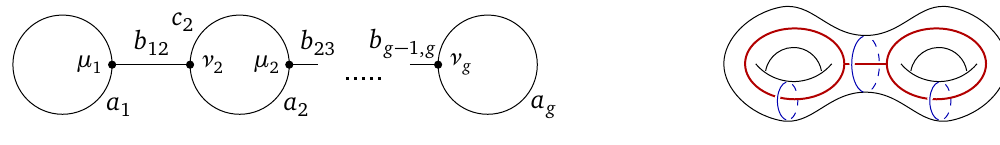
Figure 5: Left: a basis of line insertions in a genus- g handlebody that generate the Hilbert space of states on the boundary Riemann surface Σ insertions for g =